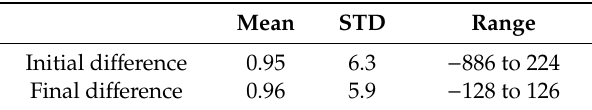
Figure 7. Void filling example of ArcticDEM data of the Zemlya Gorga Islands. Red denotes regions of voids or large errors. Table 7. Difference statistics, in meters, between ArcticDEM and WorldDEM before and after filling voids in ArcticDEM data of Zemlya Gorga Islands.